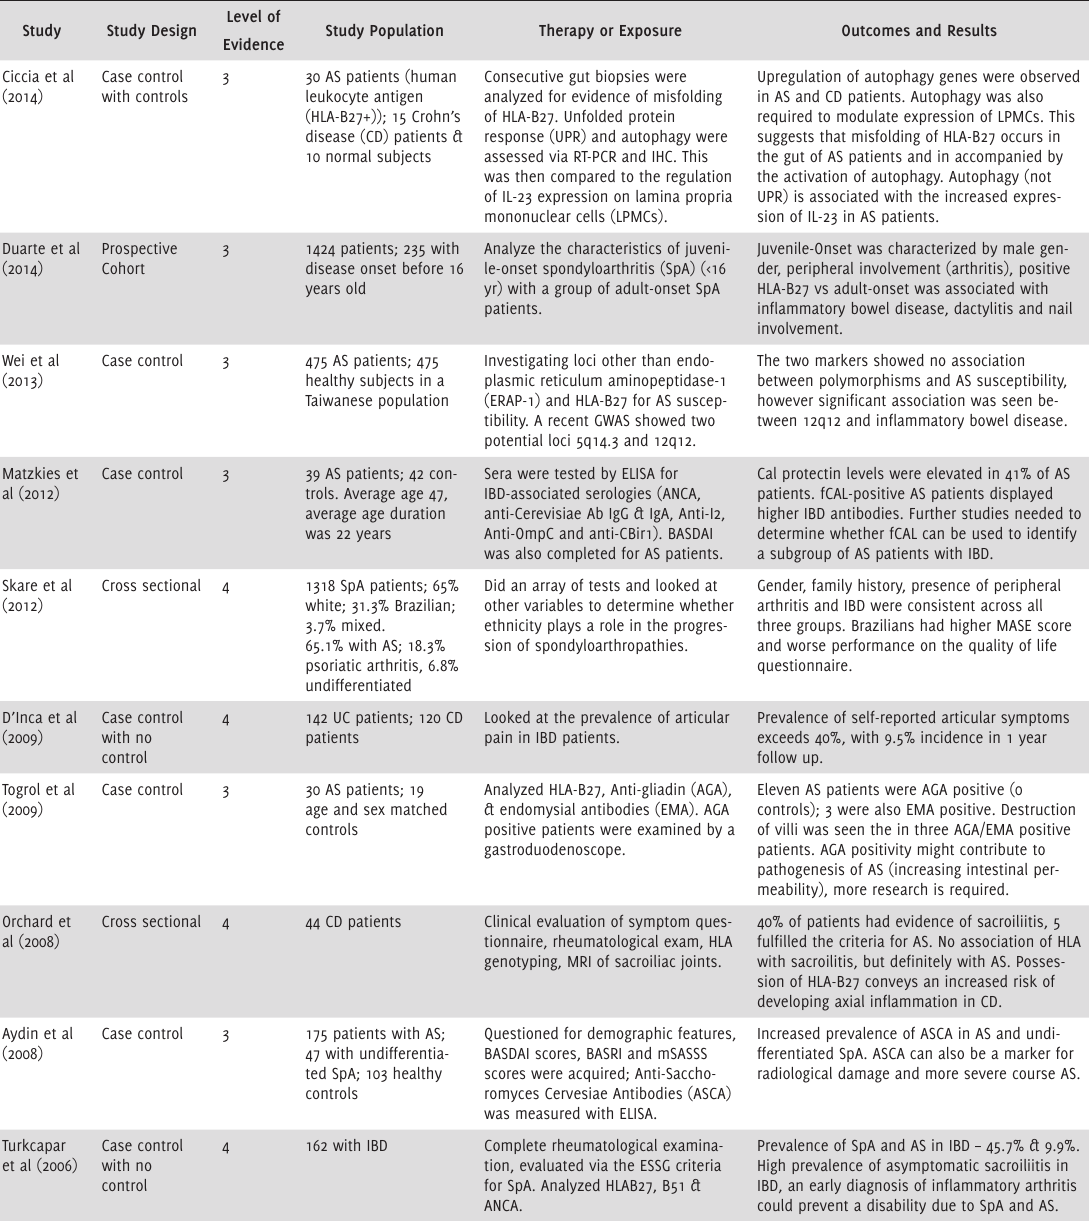
Table 1. Studies Evaluating the Genetics of Ankylosing